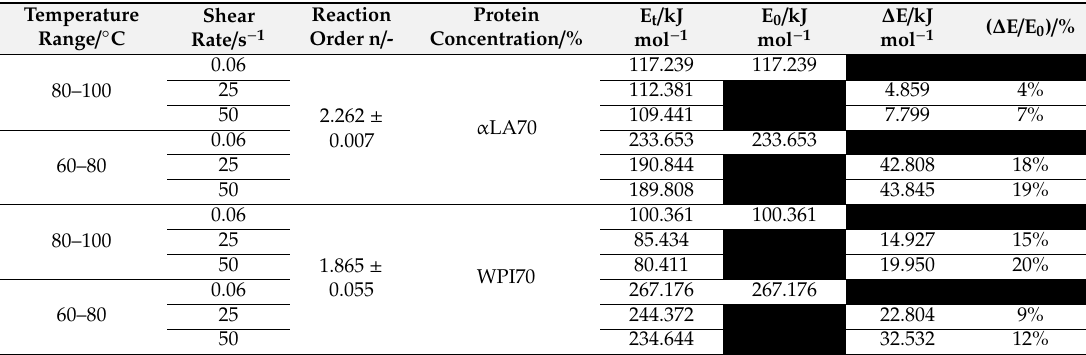
Table 2. Values of activation energy without shear stress, reduction of activation energy due to shear stress, and their ratio from the denaturation kinetic parameters for α LA and WPI samples with a protein concentration of 70% ( w / w ) at di ff erent thermomechanical treatment